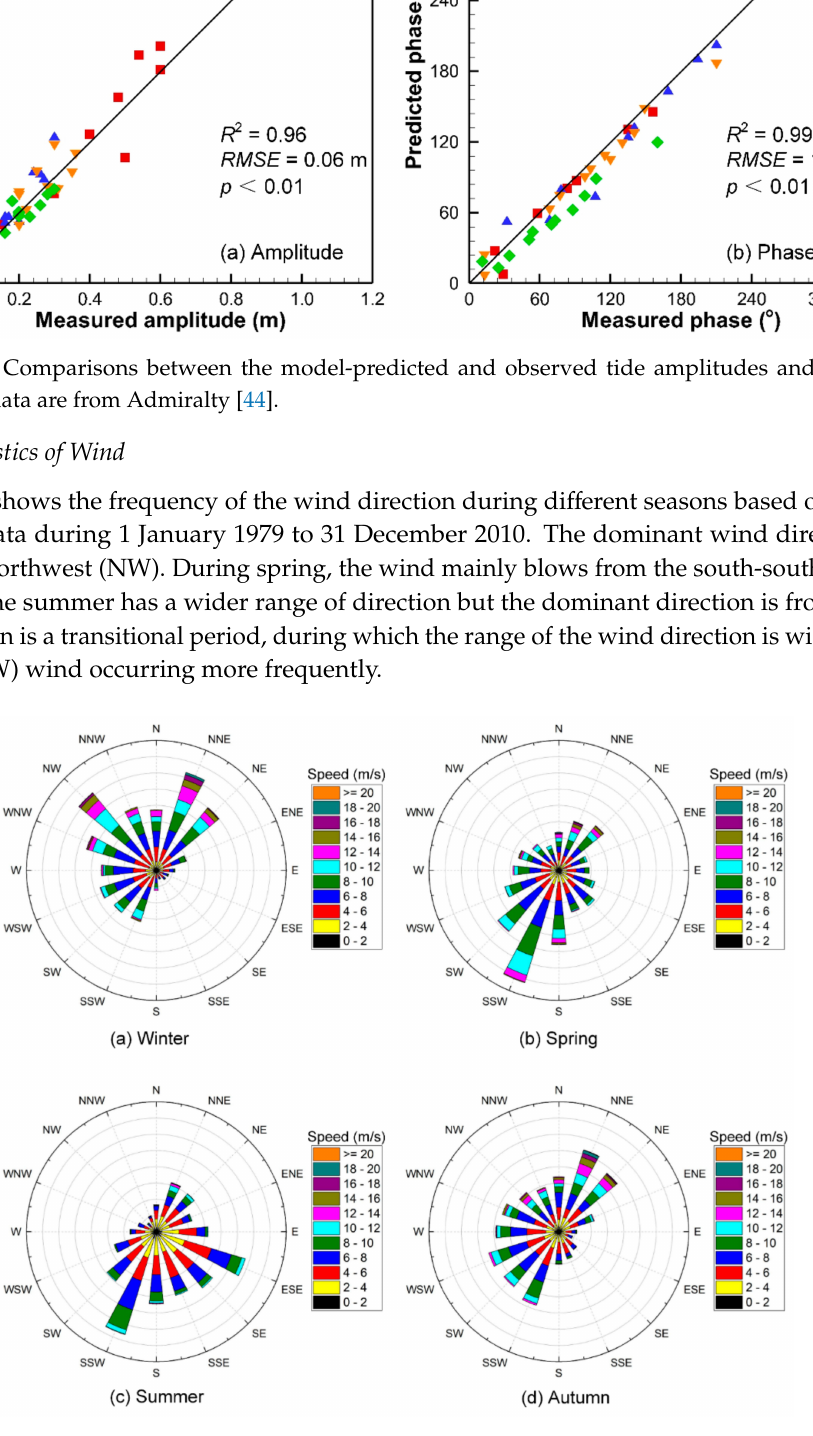
Figure 4. The wind rose (16 directions) in di ff erent seasons (based on